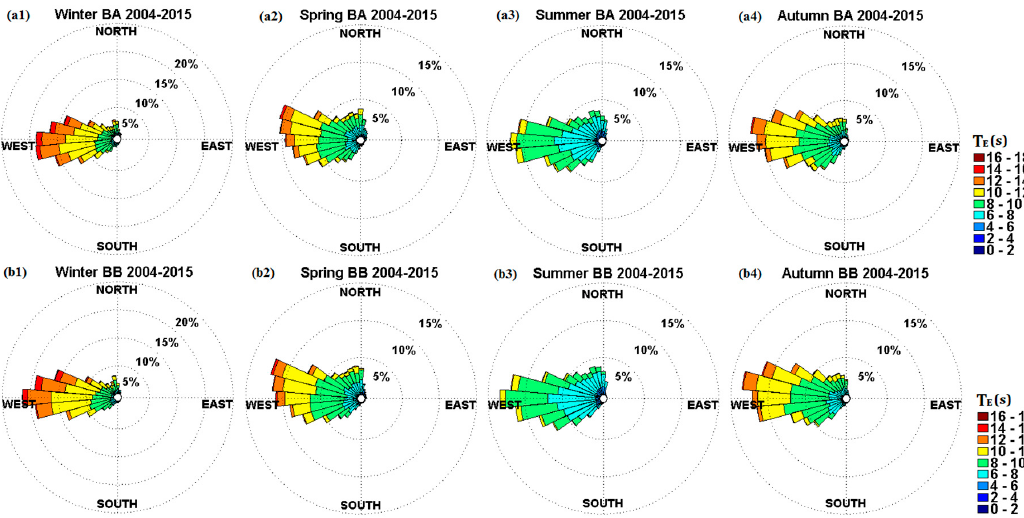
Figure 16. 12-year seasonal wave roses between T E and MWD at ( a1 – a4 ) BA and ( b1 – b4 ) BB.